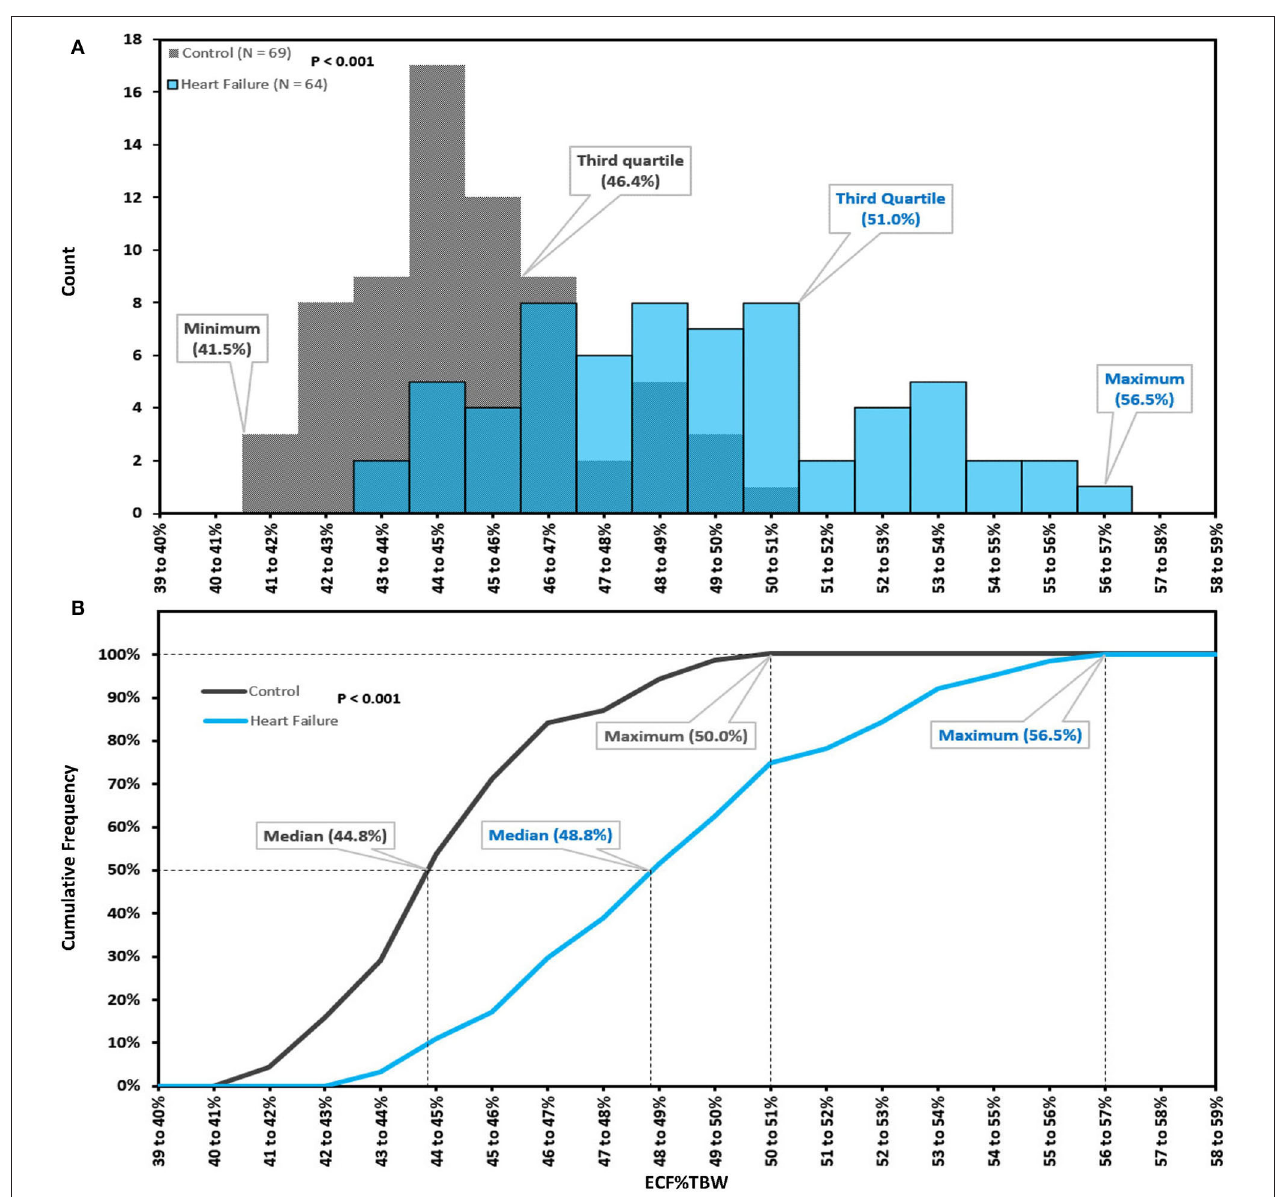
FIGURE 2 | Extracellular fluid percentage of total body water; histogram (A) , cumulative frequency curves (B) . Extracellular fluid percentage of total body water (ECF%TBW) for Healthy Control Subjects (CON-pop, N = 69, shown in gray) and Heart Failure Patients (HF-pop, N = 64, shown in blue); histogram (A) , and cumulative frequency curves (B)